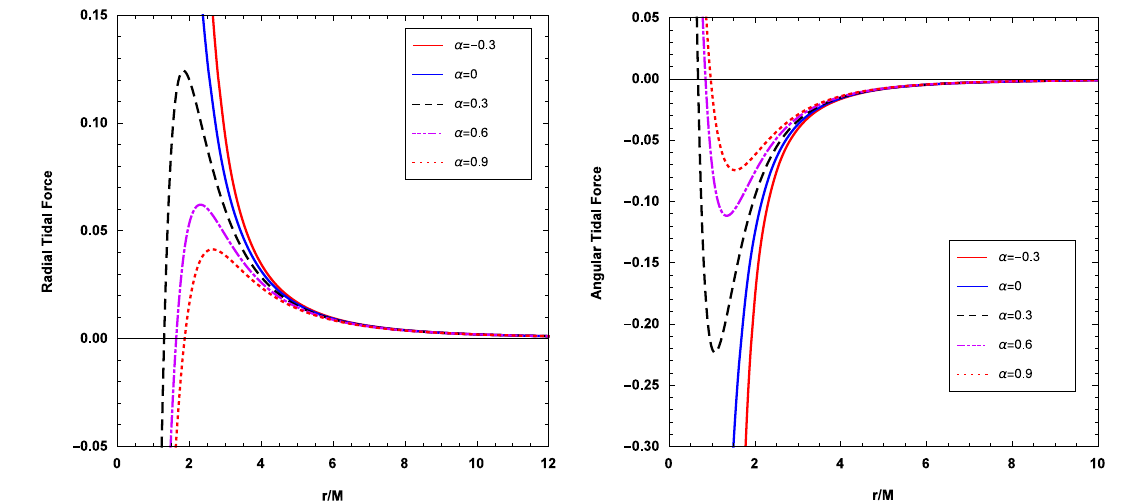
Fig. 1 The tidal forces in 4D Einstein–Gauss–Bonnet black hole spacetime with different α . The position of r + and r − are marked with the chartreuse and the deep red, respectively. The left panel is for the tidal force and the right panel is for the angular one. Here we set M = 1 and b = 100 M